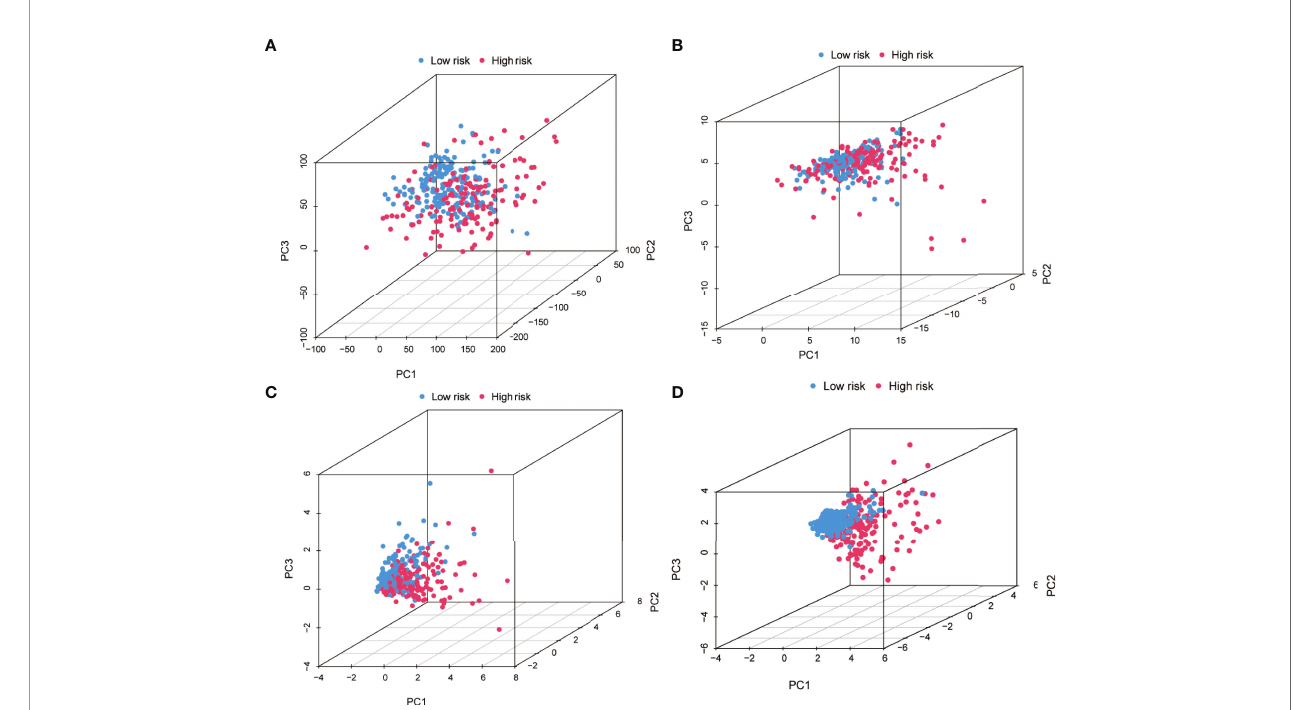
FIGURE 7 | Principal component analysis between the high-risk and low-risk groups based on (A) entire gene expression pro fi les, (B) 52 PRGs, (C) PR-lncRNAs, and (D) risk model based on the fi ve PR-lncRNAs in the entire set.